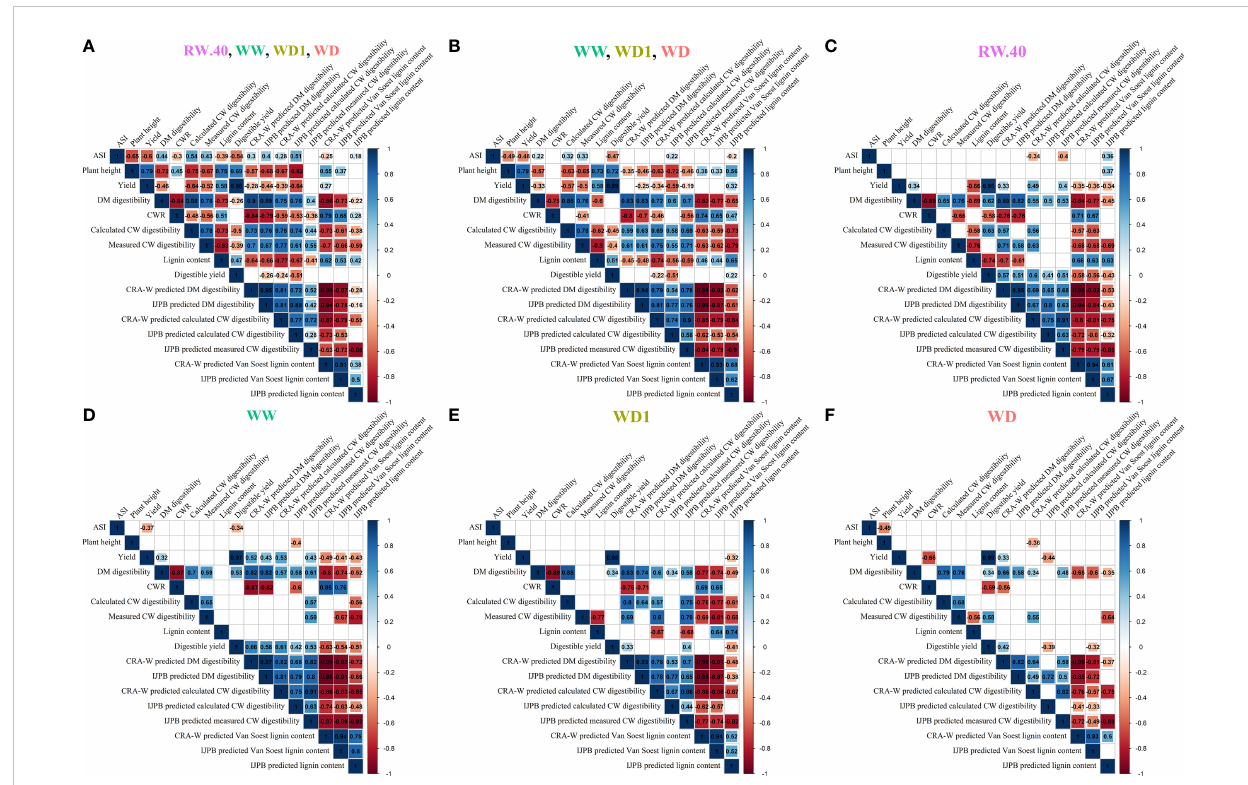
FIGURE 5 Correlation matrices for the main considered agronomic, biochemical and NIRS-predicted variables observed during the study at the different fi eld trial locations and under different conditions. Correlation matrices for all variables considered, including some used for computational purpose only, separately for all conditions combined in (A) , for all Mauguio site conditions in (B) , for the main-Versailles RW.40 condition retained for the study in (C) , and then separately for the three Mauguio conditions of WW in (D) , WD1 in (E) , and WD in (F) . Pearson correlations with correlation values in black on the matrix, signi fi cance threshold P = 5%. Empty squares indicate non-signi fi cant